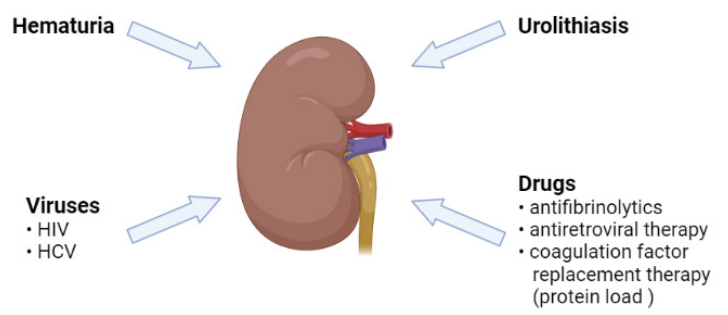
Figure 2. The major determinants of renal dysfunction in patients with congenital hemophilia.